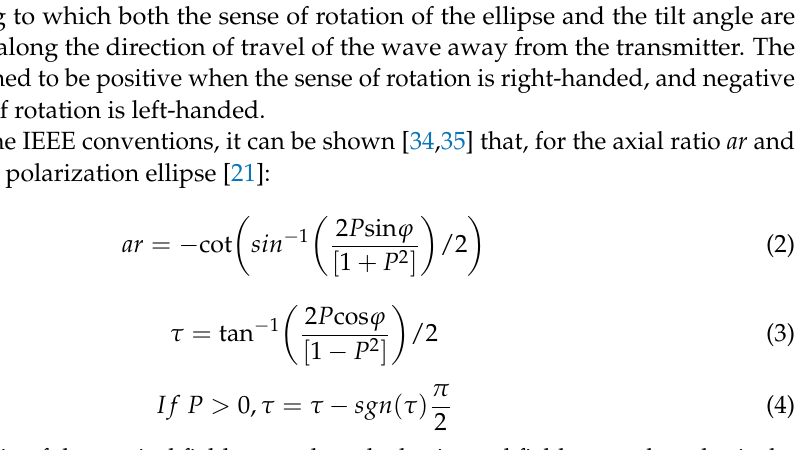
phase difference between the two fields. Tilt angle τ is defined to be in the range ± 90 ◦